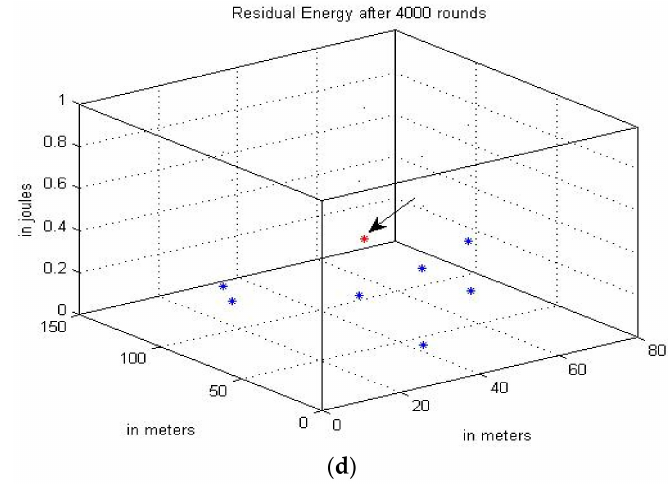
Figure 7. Residual Energy of nodes after 500, 1000, 3000 and 4000 rounds (FPLE). ( a ) Remaining Energy after 500 rounds. ( b ) Remaining Energy after 1000 rounds. ( c ) Remaining Energy after 3000 rounds. ( d ) Remaining Energy after 4000 rounds.